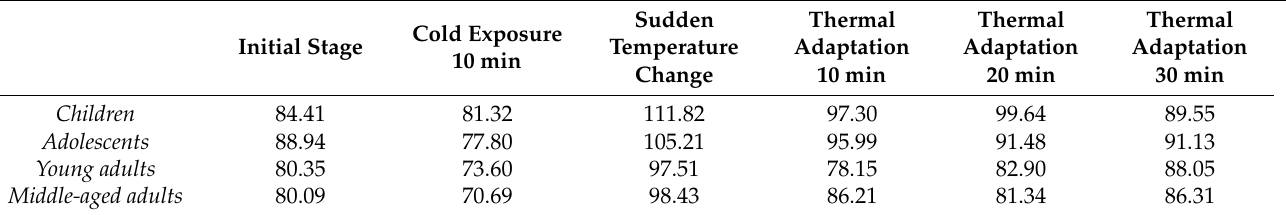
Table 8. HRs of different age-groups in different temporal phases under the 24 ◦ C condition.